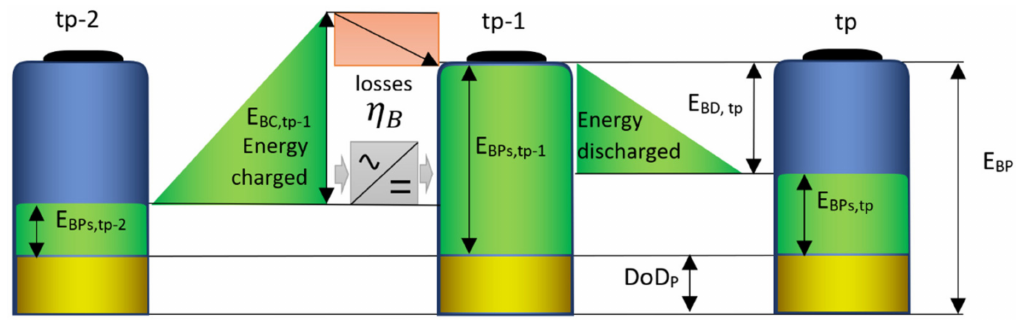
Figure 4. The different operating states of